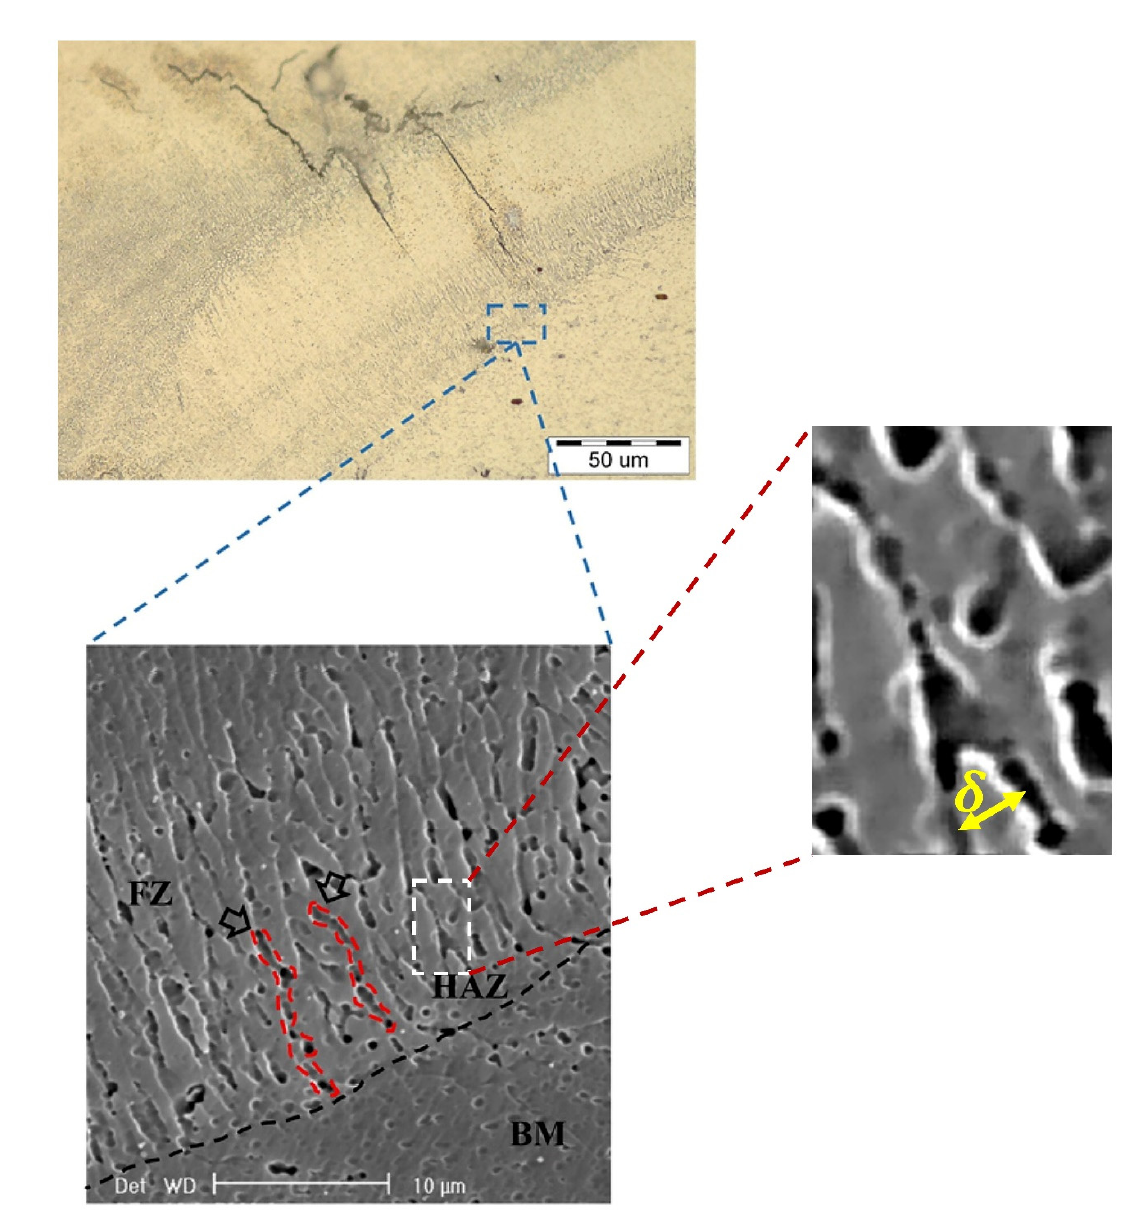
Figure 11. Measurement of dendrite arms taken by optical and scanning electron microscopies at the boundary of fusion zone using a laser with an average power of 60 W, welding velocity of 2 mm.s − 1 , and absorption coefficient of 0.36.